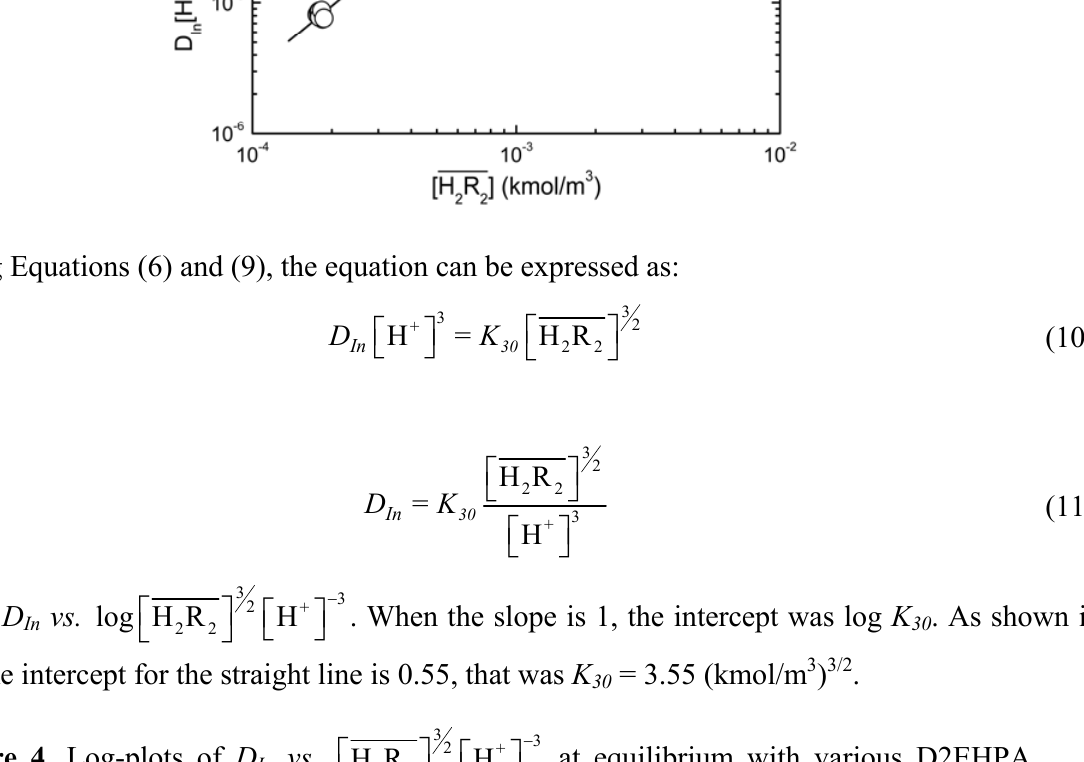
at equilibrium with various D2EHPA vs.  In   